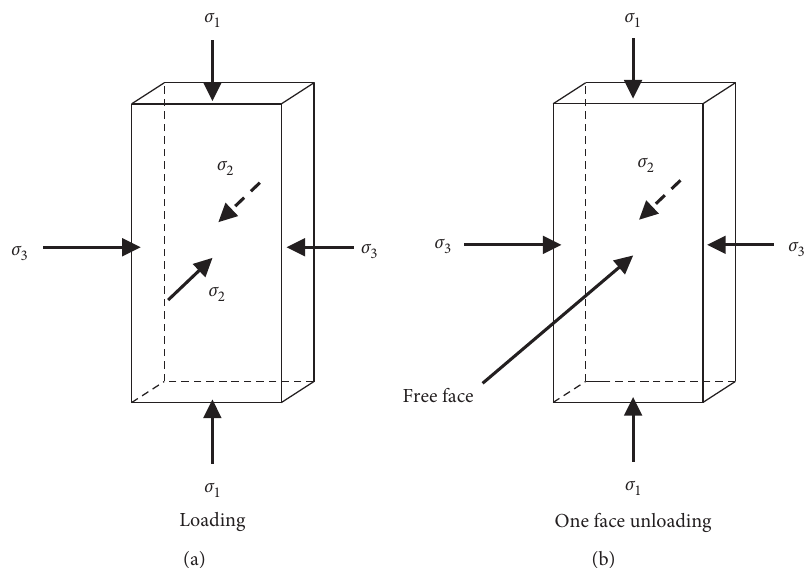
Figure 11: Loading and unloading sketchy diagram of rock-like